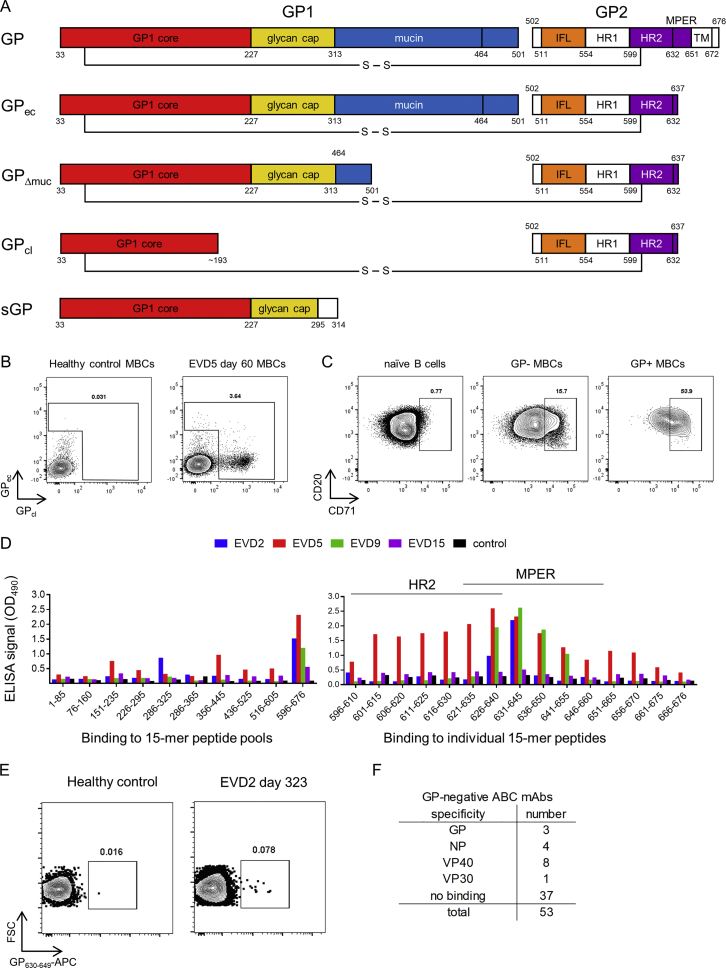
Strategies for Isolating GP-Specific mAbs, Related to Figure 3A) Recombinant glycoprotein (GP) isoforms used for B cell sorting and antibody screening. The constructs shown are: GP = full length mature EBOV glyocoprotein (expressed on Jurkat cells and used for mAb screening); GPec = GP ectodomain residues 1-636 (used as sort probe and for ELISA); GPΔmuc = GP delta mucin (used for ELISA); GPcl = protease-cleaved GP (used as sort probe and for ELISA); sGP = secreted glycoprotein (used for ELISA). Legend: GP1 and GP2 = two GP subunits generated by furin cleavage at residue 501. S-S = disulfide bond linking GP1 and GP2. IFL = internal fusion loop. HR1 and HR2 = heptad repeat regions 1 and 2. MPER = membrane proximal extracellular region.TM = transmembrane domain. Region coloring matches that used for the antibody competition groups defined in this study.B) Gating strategy for identifying and sorting GP-specific B cells. PBMCs were stained with lineage markers and fluorescently labeled EBOV GP proteins and analyzed by flow cytometry. Example flow cytometry staining is shown for CD20+ IgD memory B cells (MBCs) from a healthy, EBOV-naive donor (left) or from patient EVD5 60 days after onset of viral symptoms (right).C) Expression of the activation marker CD71 by GP-binding cells. PBMCs from EVD5 day 60 are shown. Plots are gated on CD20+ IgD+ CD27 naive B cells (left), on MBCs that did not bind GPec or GPcl (middle), or on MBCs that bound GPec and/or GPcl (right).D) Detection of plasma antibody responses to short peptide epitopes from EBOV GP. Left: Diluted plasma from the four patients or a control donor was added to ELISA plates coated with pools of overlapping 15-mer peptides spanning EBOV GP, followed by detection of bound human IgG. Right: Plates were coated with the indicated 15-mer peptides from the C-terminal peptide pool (encompassing residues 596-676 of GP). ELISA results are shown for EVD2 and EVD9.E) Sorting MPER-specific B cells. A synthetic peptide spanning GP residues 630-649 was conjugated to APC and used to identify MPER-specific B cells from EVD2.F) Binding of ABC-derived mAbs to EBOV antigens. mAbs were tested for binding to ELISA wells coated with recombinant EBOV proteins. mAbs were considered GP-specific if they bound GPec, GPcl, or GPΔmuc.